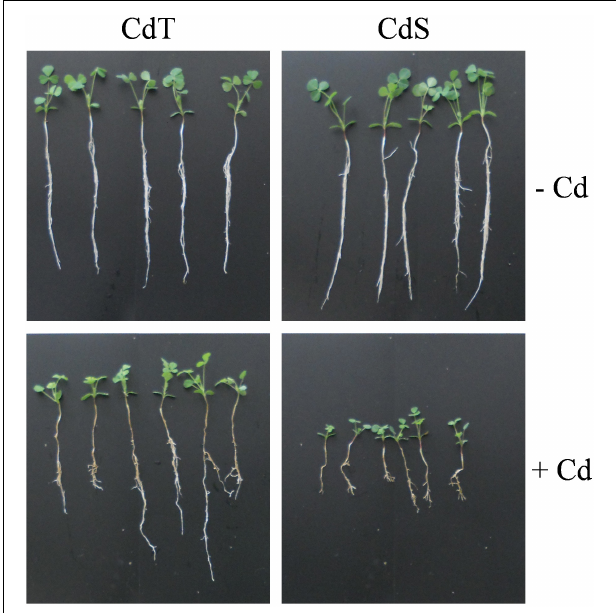
FIGURE 9 | Representative image of the plant growth M. truncatula cultivars CdT (tolerant) and CdS (sensitive) grown in pots containing vermiculite with 0 or 100 µ M CdCl 2 for 15